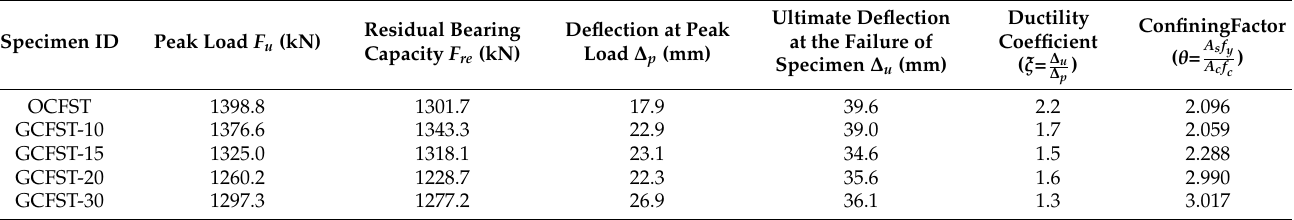
Table 3. Summary of the test